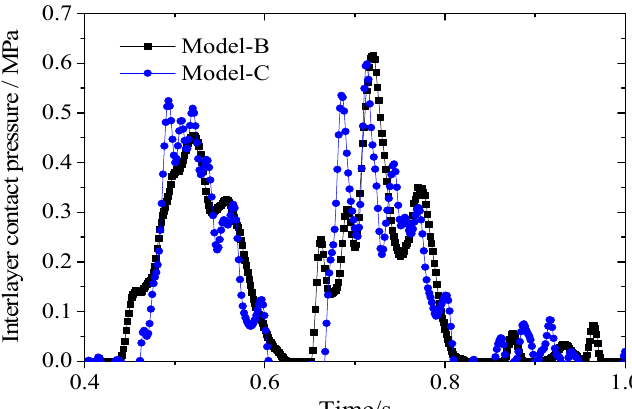
Figure 13. Time history of interlayer contact pressure with Model-B and Model-C.